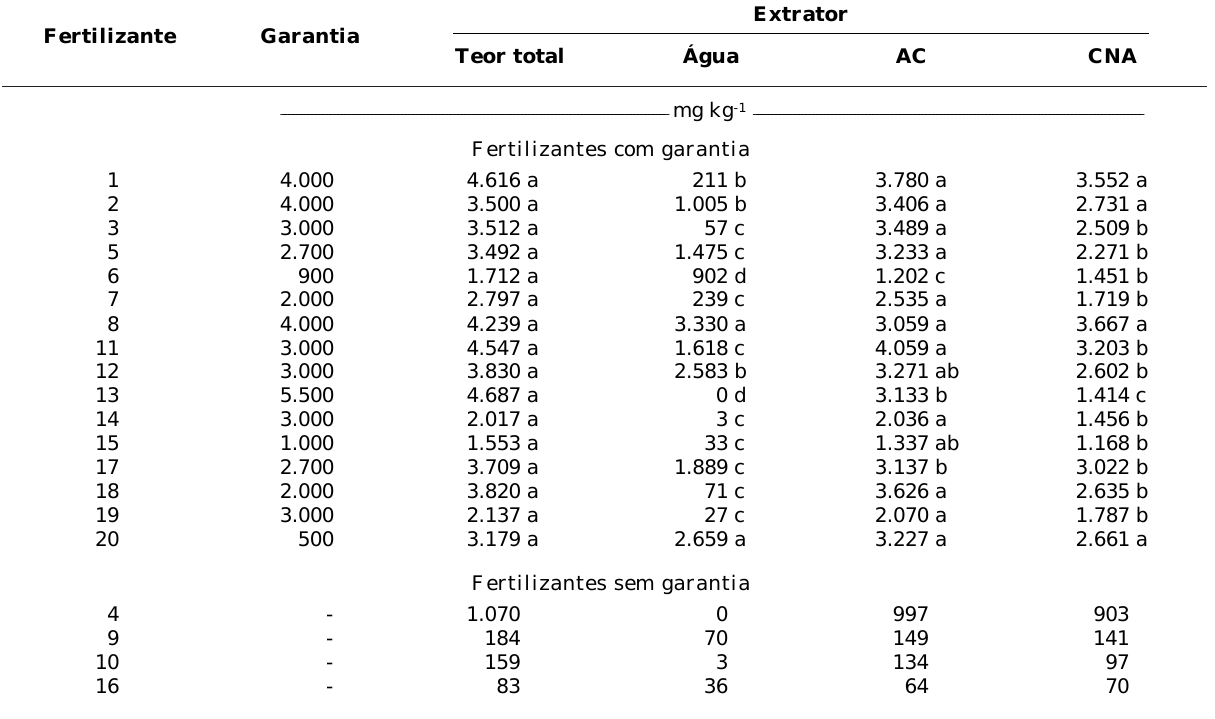
Quadro 2. Teores de zinco, extraídos pelos diferentes extratores, nos fertilizantes com e sem garantia do